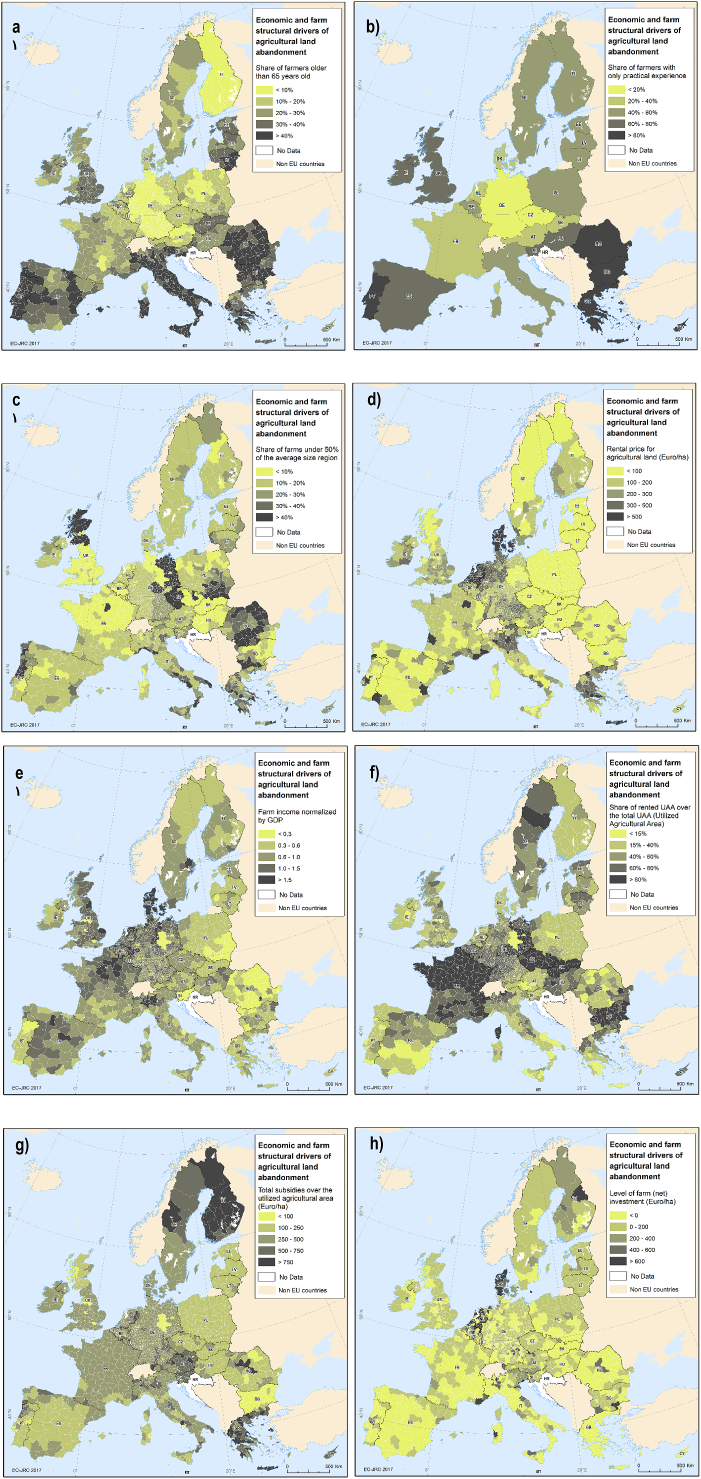
Individual economic and farm structural factors for determining the stability and viability of farming activities for preventing agricultural land abandonment in the EU countries and the UK. a) Share of farmers older than 65 years old, b) Share of farmer with only practical experience, c) Share of farms under 50% of the average size region, d) Rental price, e) Farm income, f) Share of rented UAA, g) Total subsidies and h) Farm investment.